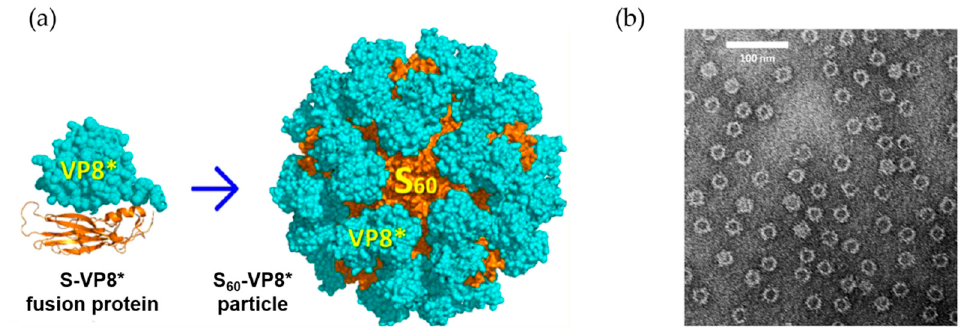
Figure 3. The utilization of norovirus capsid as antigen carrier. ( a ) Scheme for the fusion S domain of norovirus capsid with rotavirus VP8* protein and construction of the assembly structure. ( b ) Electron microscopy images of the S 60 -VP8* particles. Reprinted with permission from [20]. Copyright (2018) American Chemical Society.